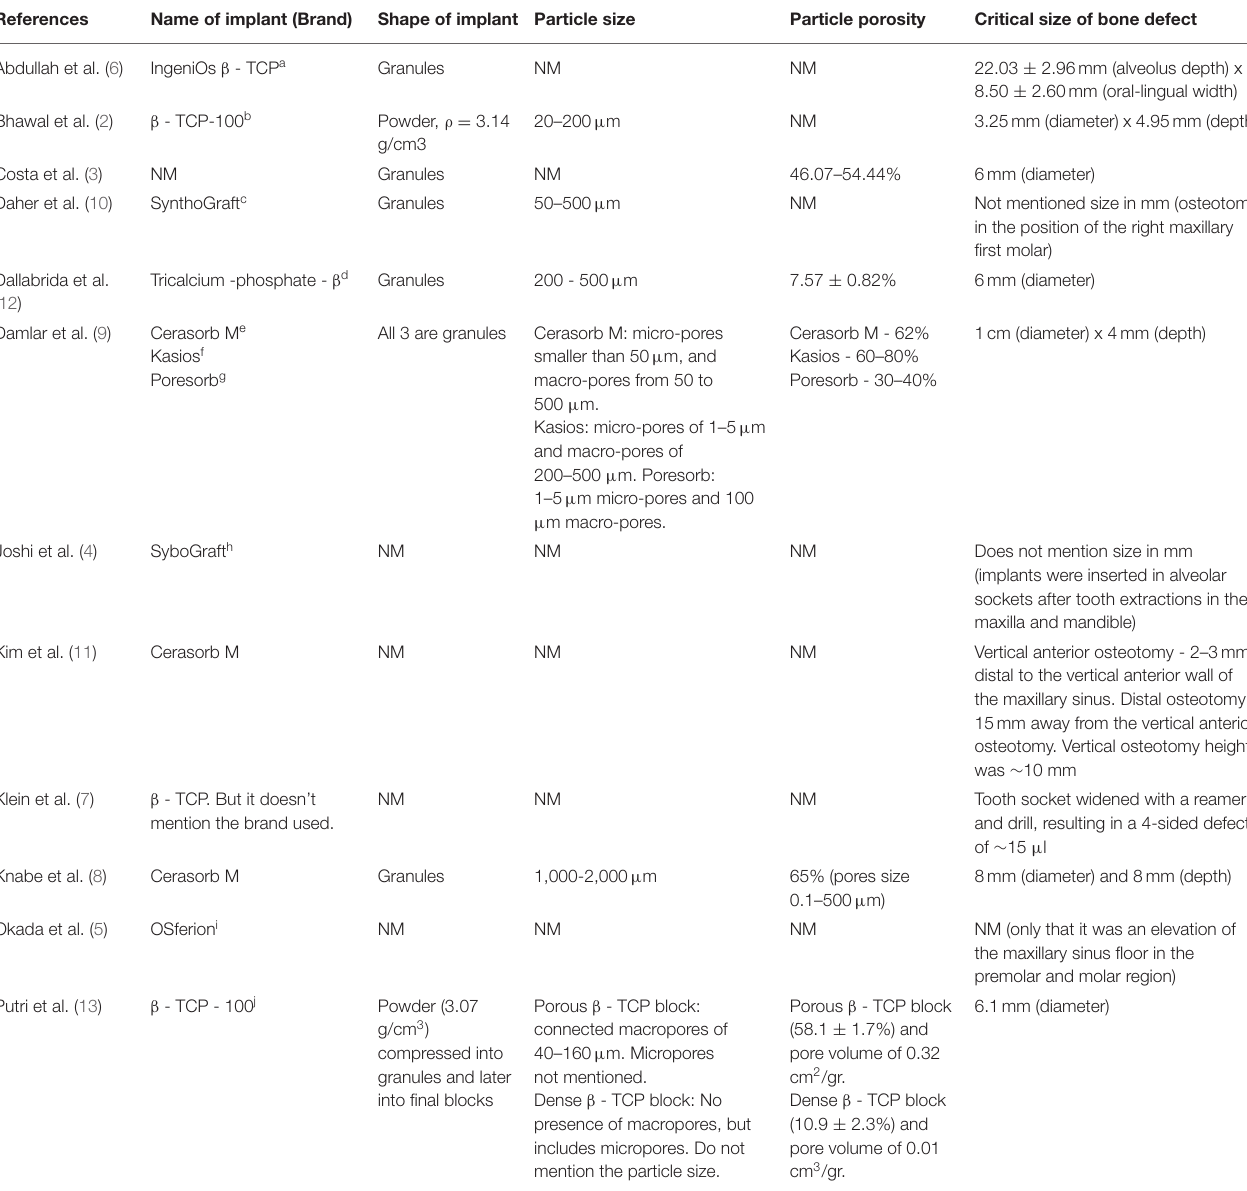
TABLE 5 | Brand, shape, porosity, and particle size of the implants used by the